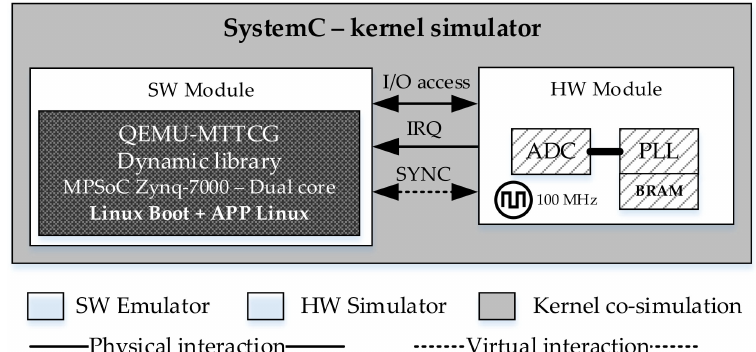
Figure 12. Linux + HW setup. QEMU-MTTCG inside a co-simulation virtual platform as software simulator. ADC and PLL IP accelerators in hardware